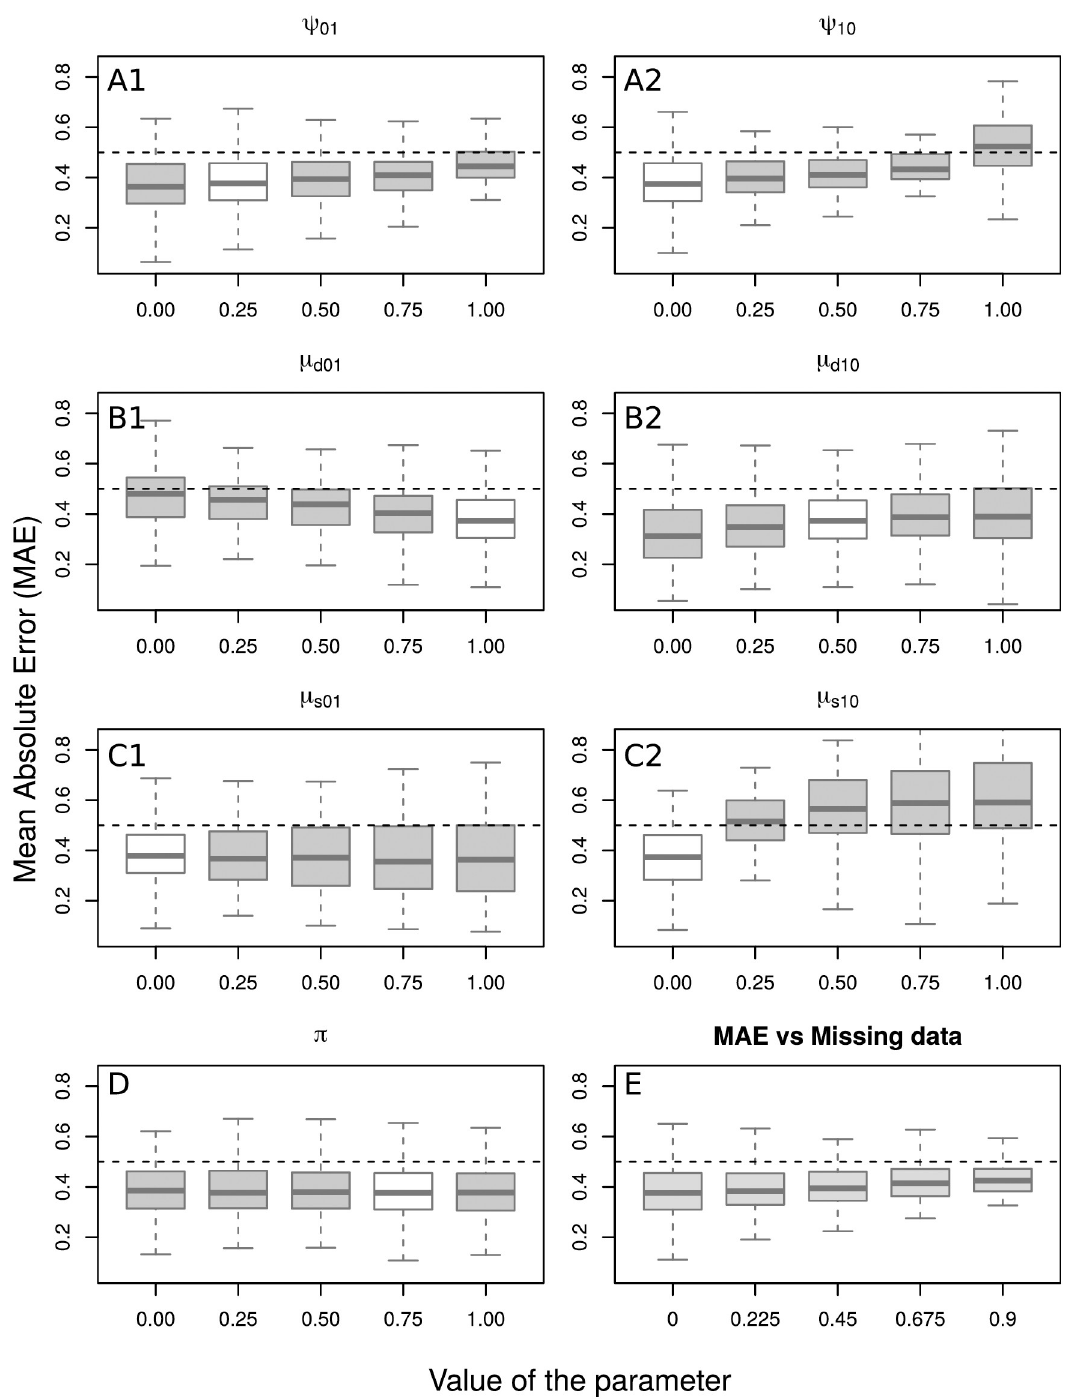
Fig 2. Sensitivity analysis. Boxplots of MAEs as a function of single parameter updates. Sub-figures A1 through D show how the MAEs change as a function of fixing the given parameter value ranging from 0 to 1. In each of these plots, the white box indicates the parameter value used to generate the data (i.e., the “correct” parameter value). The last boxplot, sub-figure E, shows the distribution of the MAEs as a function of the amount of available annotation data, that is, how prediction error changes as we randomly remove annotations from the available